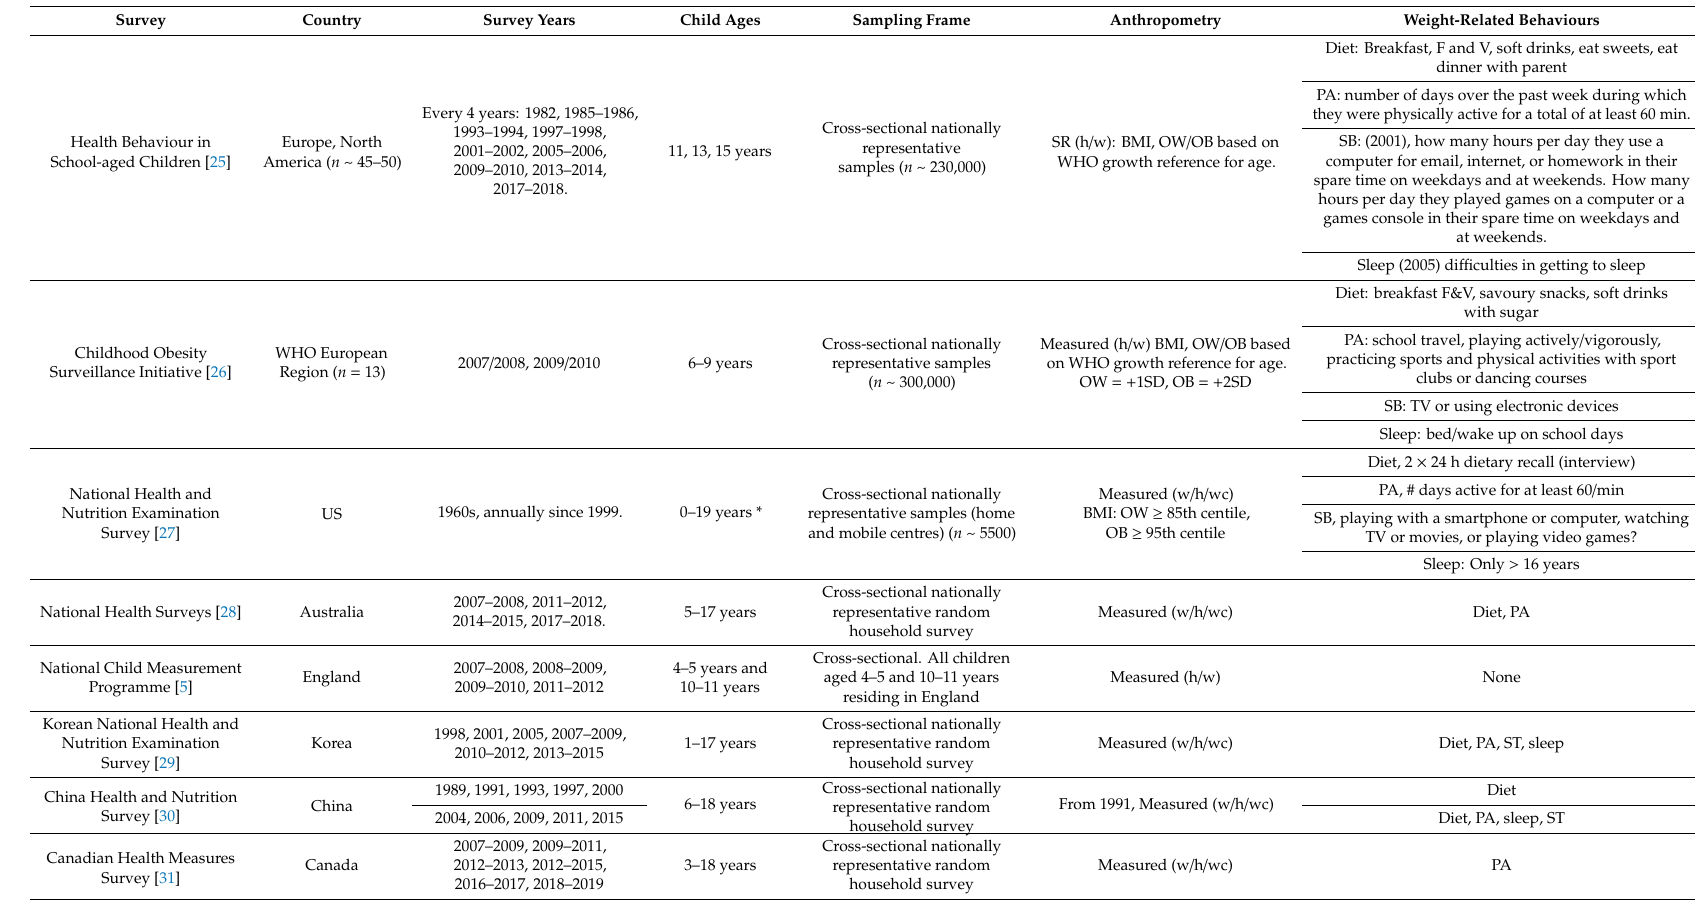
Table 1. Selected examples of population child health